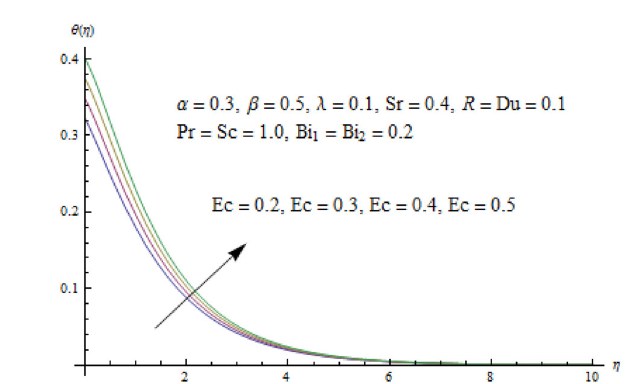
Fig. 23 Impact of and Ec θ(η)